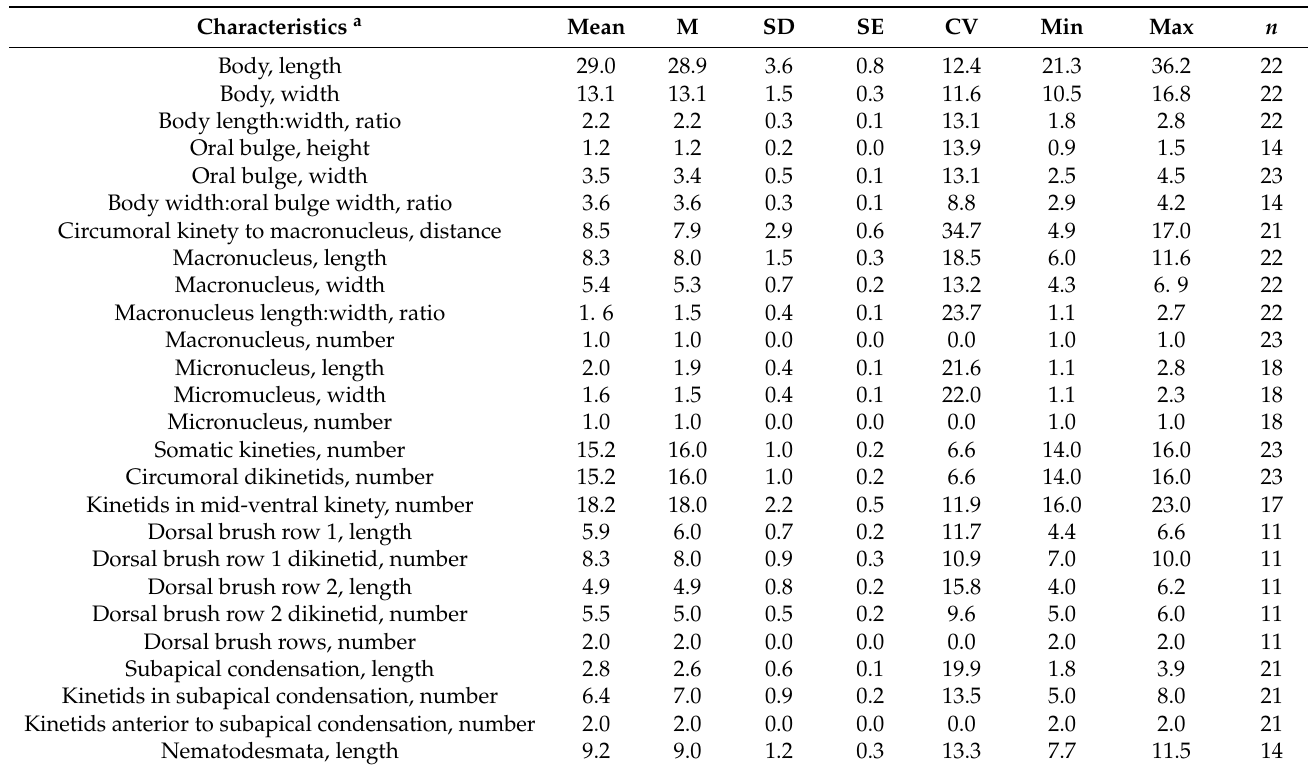
Table 1. Morphometric data on Fuscheriides baugilensis sp.